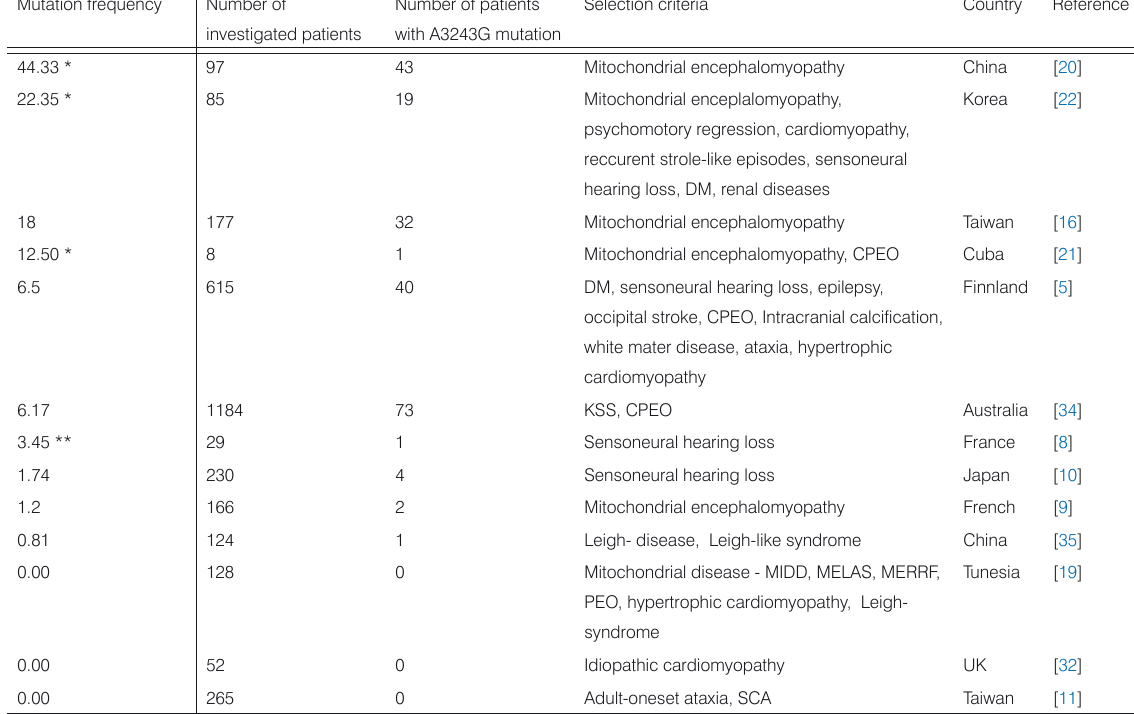
Table 3. The mtDNA A3243G mutation frequencies among the patients with mitochondrial diseases in different countries (* Patients were selected on the basis of results of muscle biopsy; ** Patients were selected on the basis of the result of Mitochip microarray).